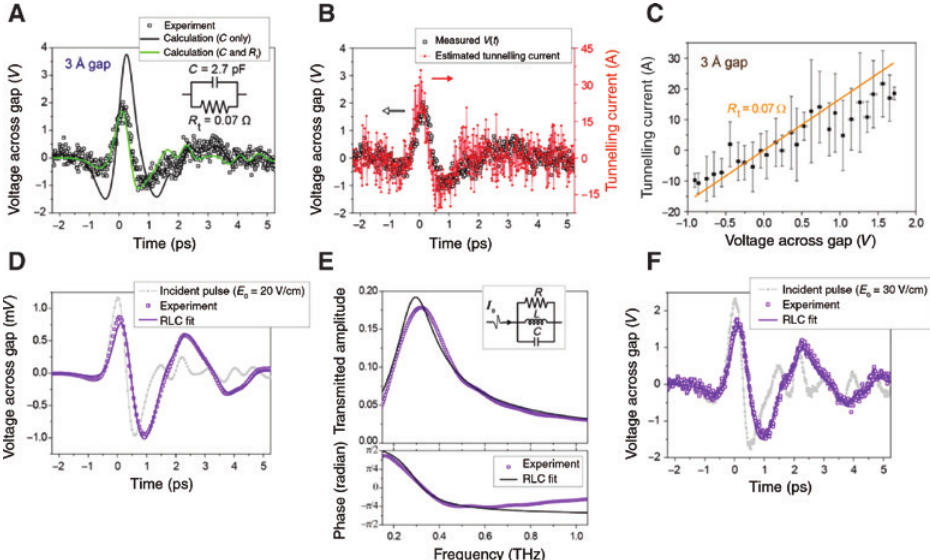
Figure 12: Terahertz tunneling transport in metal angstromgaps. (A) Measured voltage time trance through a 3-angstrom–sized metal–graphene–metal gap at an incident field strength of 30 kV/cm. The inset shows the equivalent circuit of the gap. (B) Measured voltage across the gap V ( t ), which is identical to the experimental data in (A), and the extracted tunneling current. An unweighted sliding-average smooth of 11 data points is applied to the tunneling current to produce a less noisy temporal amplitude profile. (C) An I - V plot obtained from the results of (B) and a line that represents a tunneling resistance R Temporal profile of the voltage across the alumina gap and the corresponding Fourier-transformed amplitude and phase of terahertz waves transmitted through the nanoslot array at an incident field strength of 20 V/cm. The inset in (E) shows the equivalent circuit of the nanoslot array. (F) Transmission through the same sample by a terahertz pulse with a field strength of 30 kV/cm. The figures are reproduced from Reference